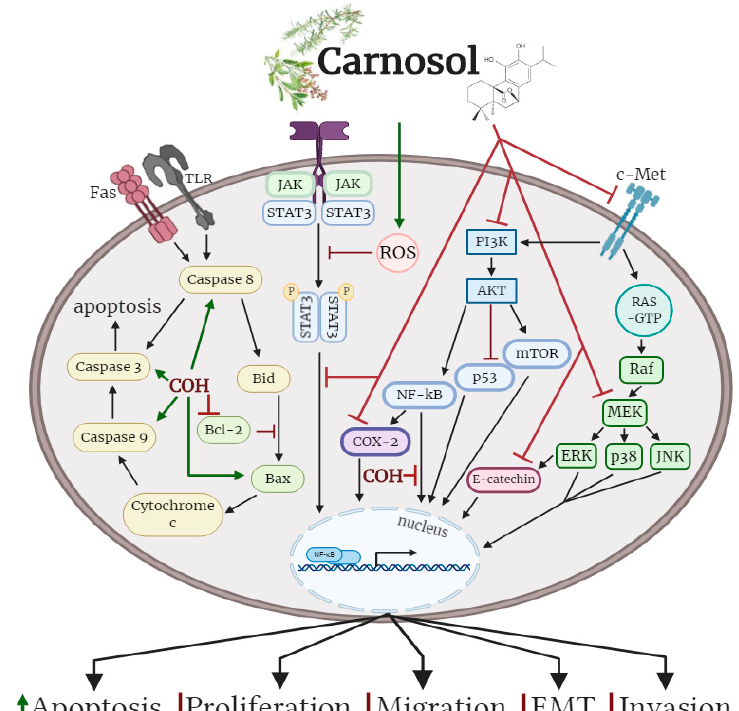
Figure 2. E ff ects of carnosol on cancer cell signalling molecules. Carnosol inhibited the phosphorylation / activation levels of ERK, p38, JNK, Akt, mTOR and COX-2. The nuclear translocation of NF- κ B was prevented with carnosol, sequestering NF- κ B in the cytosol. Pro-apoptotic caspase-3, -8, -9 and BAX protein levels were increased, while anti-apoptotic protein Bcl-2 was reduced with carnosol. The figure is based on the data of the studies [40,43,46,49,53,56,60,61,68,69,75,79] and created with BioRender.com. COH: carnosol.